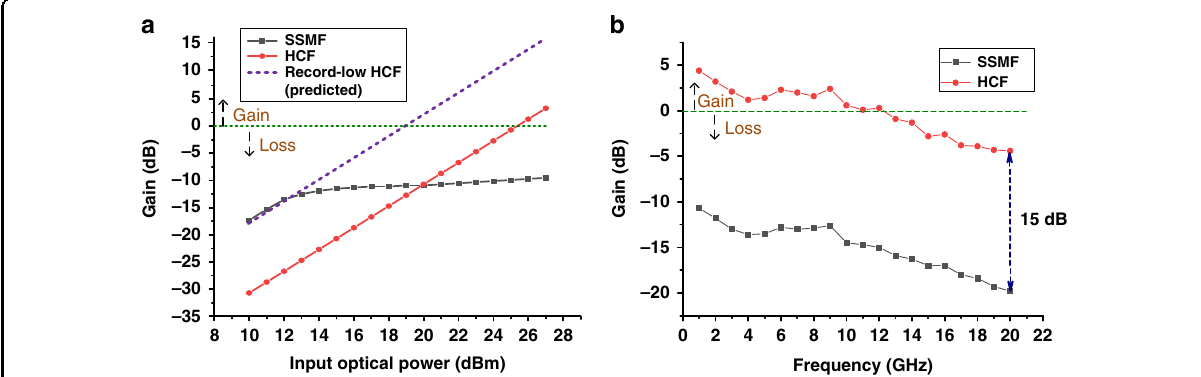
Fig. 3 Measured Q-biased APL gain (set-up shown in Fig. 2). a Gain is plotted as a function of the optical power launched into the transmission fi bre. The input signal has a frequency of 1 GHz. The measured gain with the SSMF transmission fi bre is shown as a solid line with square symbols) and the measured gain with the HCF transmission fi bre is shown as a solid line with circle symbols. The predicted gain considering a HCF transmission fi bre with the lowest-published attenuation to date is shown as a dashed line. Dashed black arrows indicate net gain or loss. b Measured gain over the frequency range of 0 – 20 GHz obtained for the maximum received power as limited by SBS (SSMF APL) and photodiode (HCF APL). The HCF APL shows 15-dB higher gain than the SSMF